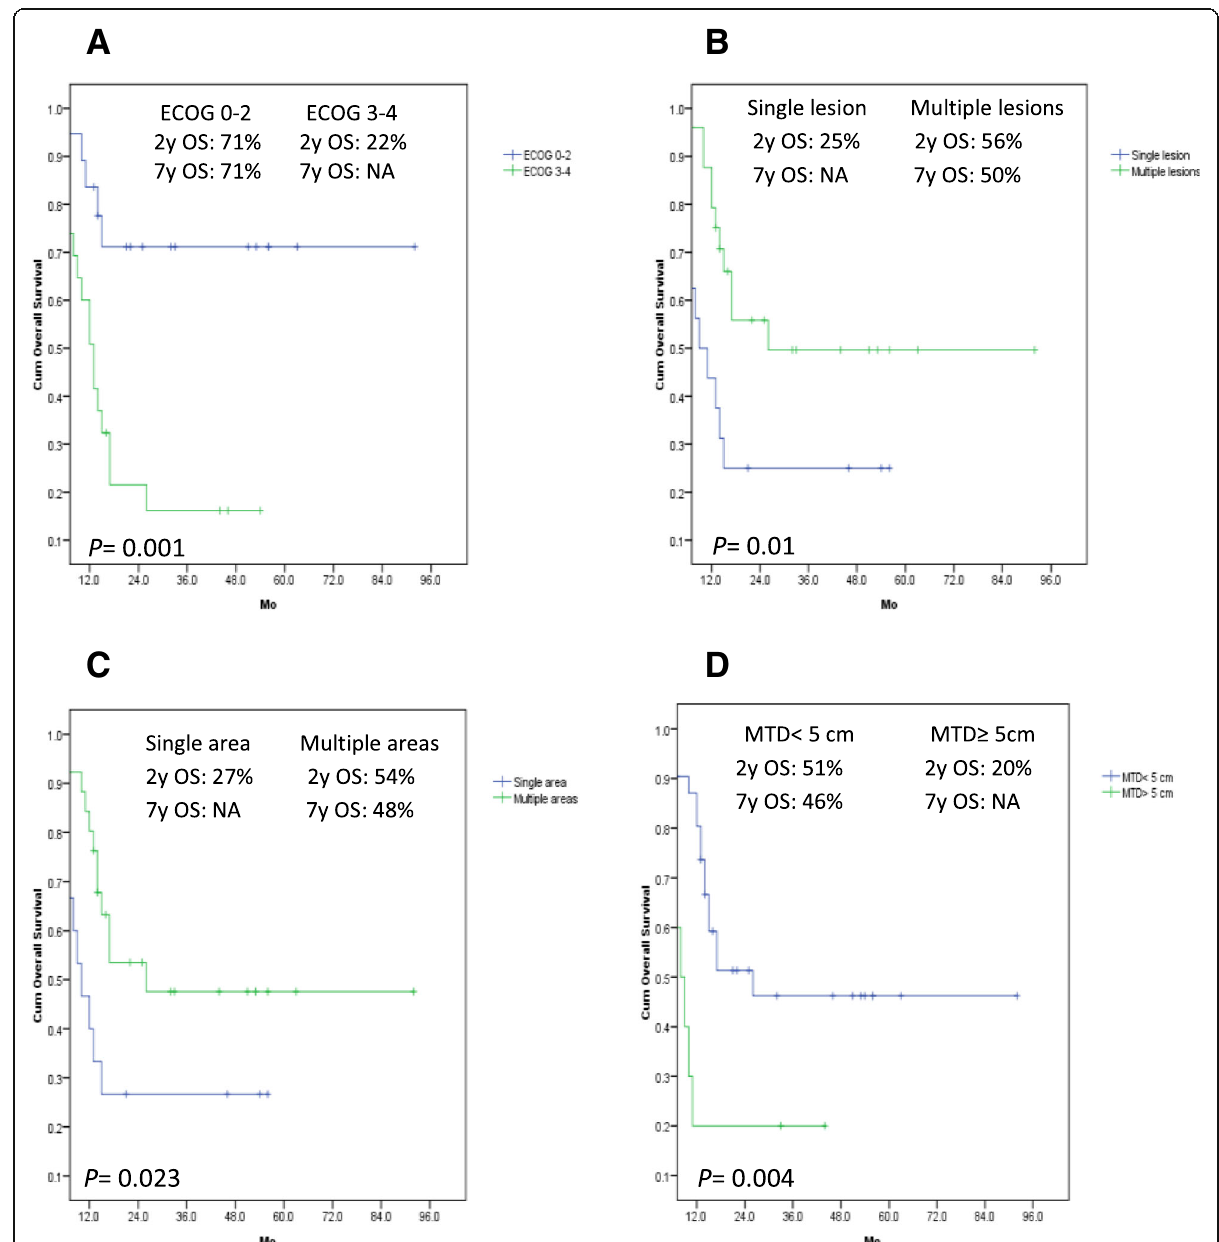
Fig. 1 OS in 43 PCNSL patients with an ECOG score ≤ 2 and > 2 ( a ), with a solitary and multiple brain lesions. ( ≥ 2 lesions) ( b ), with a single and multiple area of brain involvement ( c ), with a MTD ≥ 5 and < 5 cm. ( d